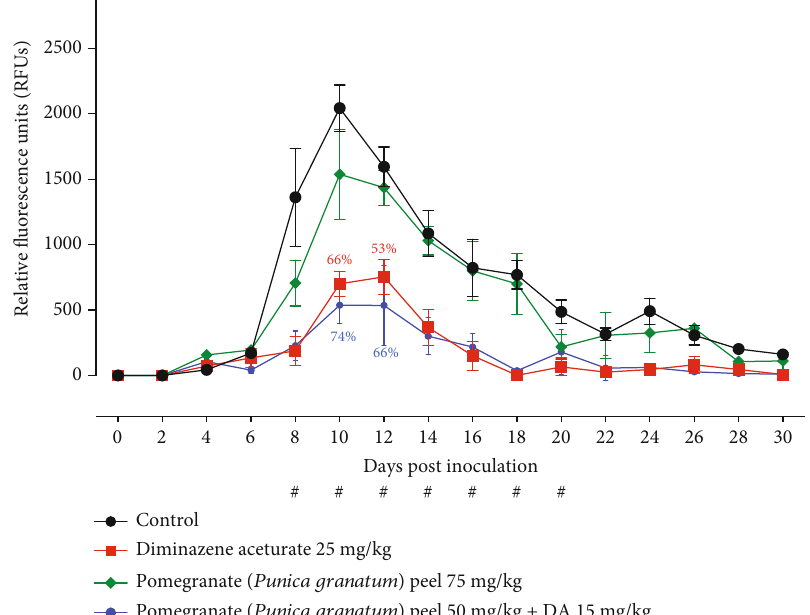
Figure 2: Inhibitory e ff ect of pomegranate ( Punica granatum ) peel mono- and combination therapies on the growth of Babesia microti in BALB/C mice. The values are presented as mean and SD of the used mice in each group. # indicates signi fi cant di ff erences ( P < 0 : 05 ) between either the pomegranate peel/DA or DA monotherapy-treated and control